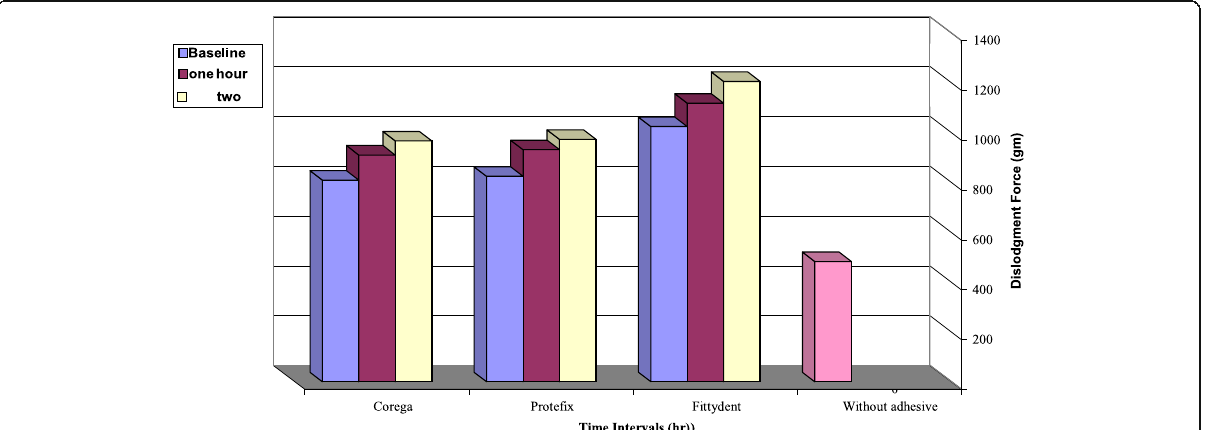
Fig. 2 Mean dislodgement forces of poorly fitting mandibular complete dentures with saliva alone and at various time intervals with the use of denture